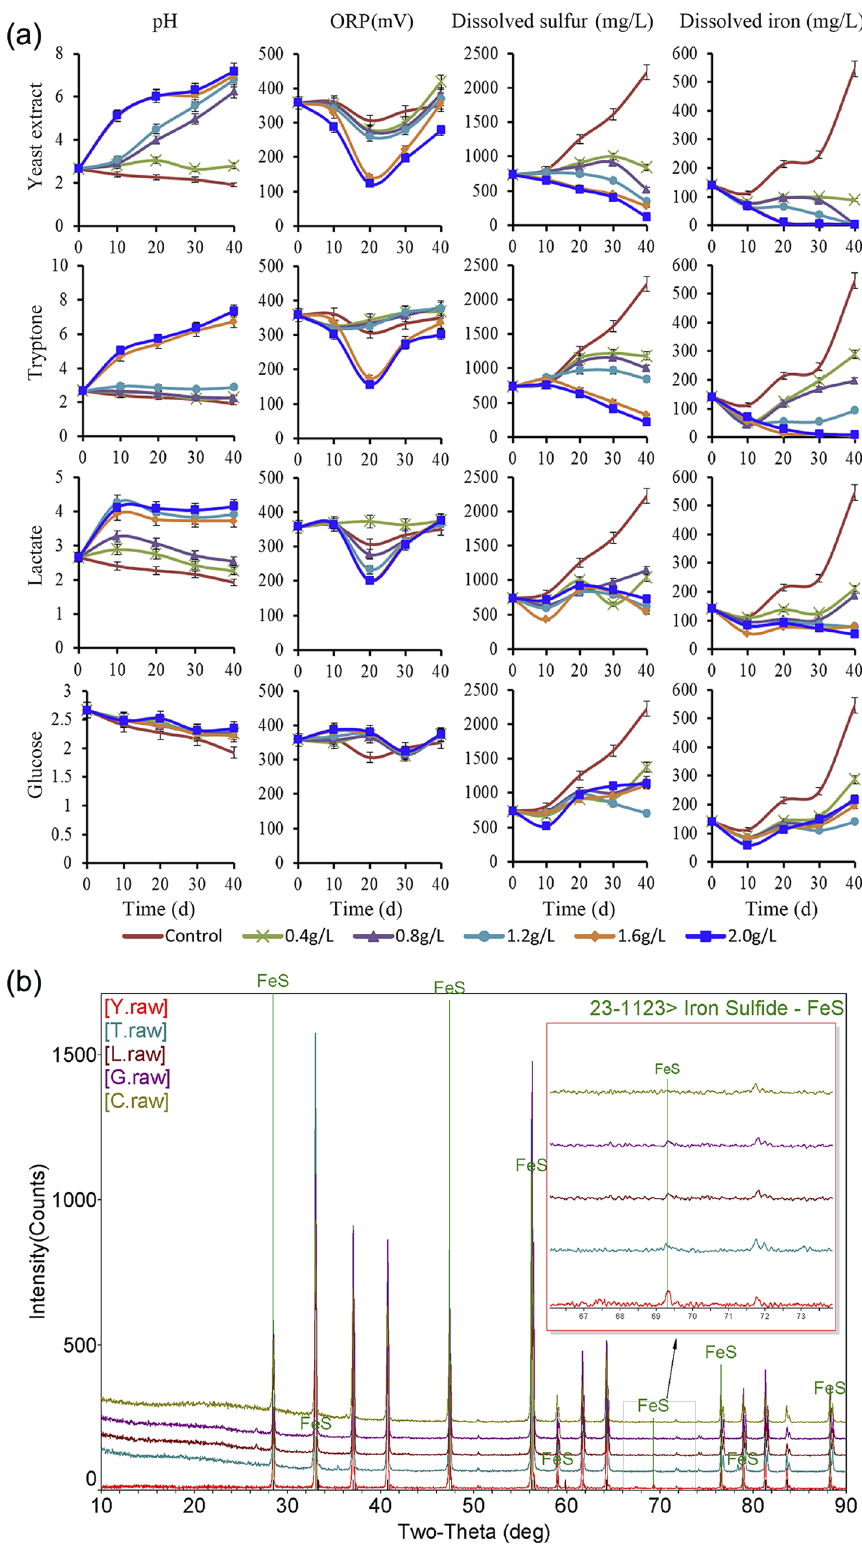
Figure 1. Remediation effects in the different groups. The physiochemical properties of different bioremediation systems (a) . Rows represent different nutrients, columns show different physicochemical parameters: pH, ORP, dissolved sulfur and dissolved iron. Identification of reaction products by XRD (b) . Yeast extract-supplemented group (Y), Tryptone-supplemented group (T), Lactate-supplemented group (L), Glucose- supplemented group (G), control group